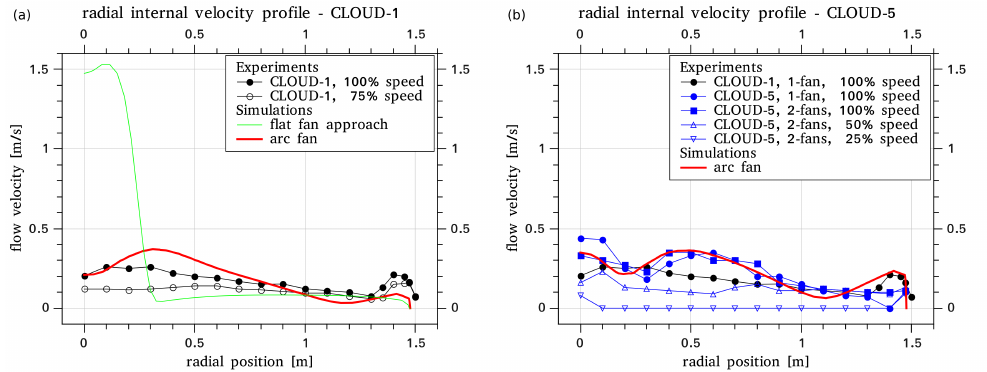
Fig. 4. Measured internal air velocity 50cm above the fan (black and blue dots) compared to simulation results. The Fig. shows results for a 1-fan configuration (CLOUD-1, (a) ) and a 2-fan configuration with hoods around the fans (CLOUD-5, (b) ). The flow direction was not measured, but probably has large azimuthal and radial components, especially in the outer region. Different shapes of the zero thickness pressure jump layer (representing the mixing fan) result in different velocity profiles. A flat fan configuration results in a velocity profile significantly different from experimental data (green line). To match the experimental data, arc shaped layers are necessary (red line).